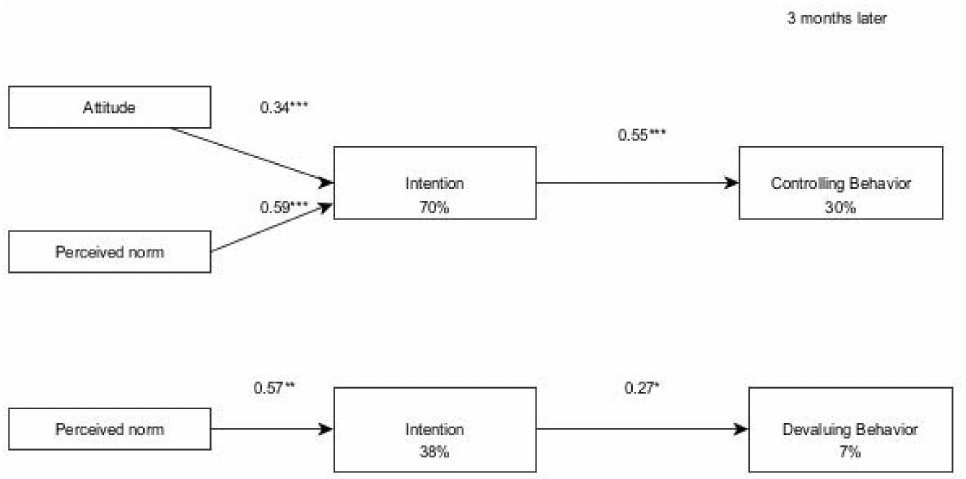
Figure 3. Final models for accepting abusive behaviours among girls in a relationship (three months after). Notes: * p < 0.05. ** p < 0.001. *** p <